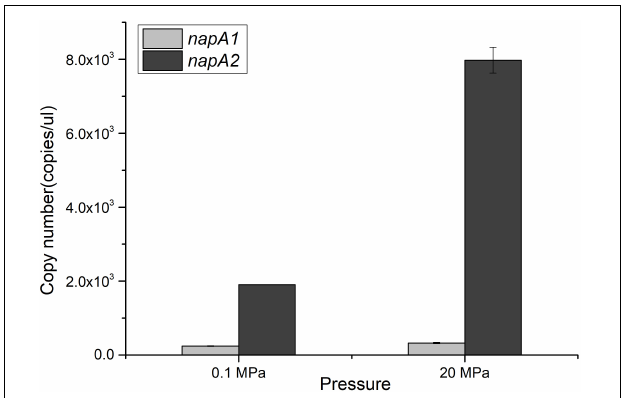
FIGURE 2 | Expression levels of napA1 and napA2 in WP3 under different pressure conditions. The copy number of napA1 and napA2 in WP3 cells cultivated under different conditions was determined by absolute quantitative RT-PCR. Each value is the average of three measurements.